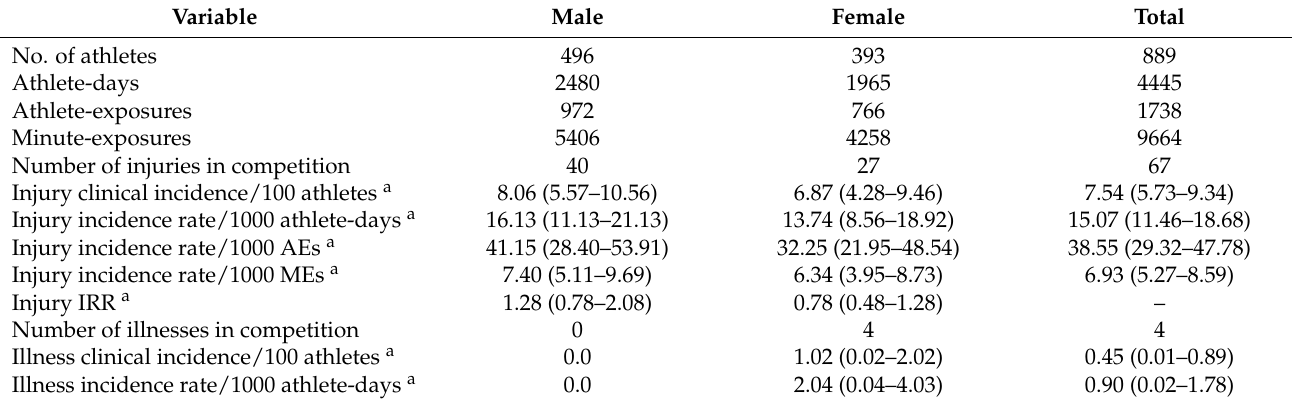
Table 1. Injury and illness characteristics of the Taekwondo athletes participating in the